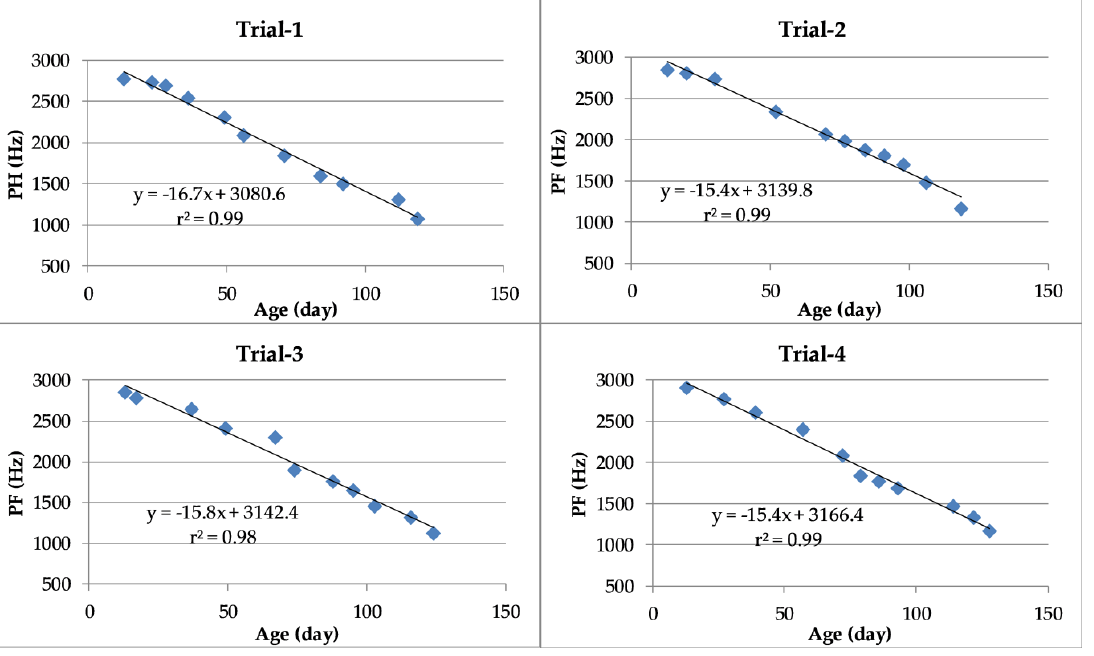
Figure 5. Linear regressions and coefficients of determination between peak frequency (PF) of turkey vocalizations and turkey age.